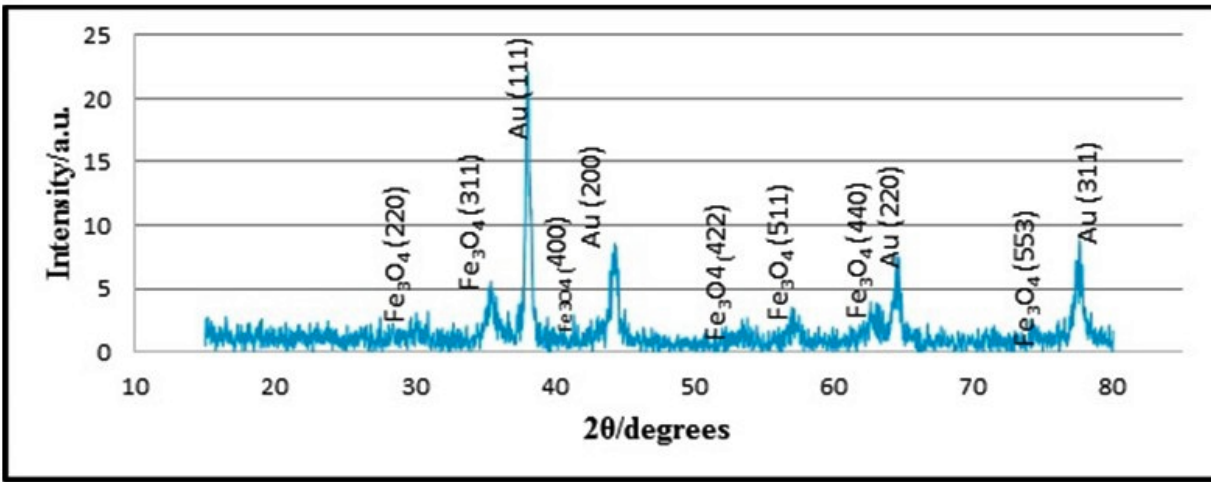
FIGURE 4 - Showed that, in the X-ray diffraction XRD pattern of gold coated Fe peaks of Fe and Au are clearly visible. XRD pattern have diffraction peaks at 2 θ = 38.2°, 44.4°, 65.6° and 77.5° which can be indexed to (111), (200), (220) and (311) planes of Au in the cubic phase (Robinson et al., 2010). Also have 30.3°, 35.5°, 43.2°, 53.5°, 57°, 62.7° and 74.5° which correspond to the (220), (311), (400), (422), (511), (440) and (533) crystallographic planes of the inverse spinel magnetite crystal (Shrifian et al., 2015). XRD results confirm the formation of gold coating on the magnetite